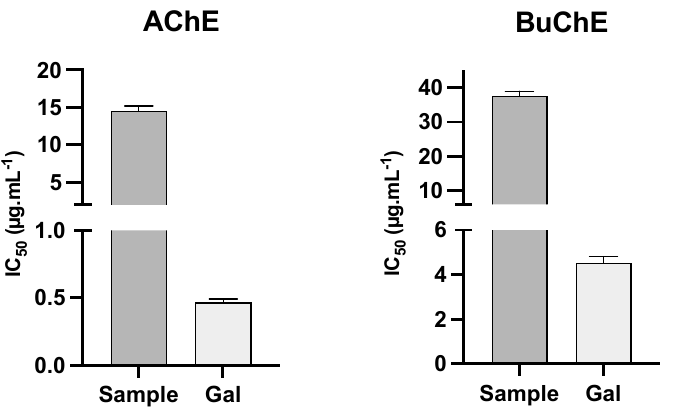
Figure 2. AChE and BuChE inhibitory activity of Ismene amancaes . Sample: alkaloid extract of I. amancaes bulbs; Gal: galanthamine (reference compound).